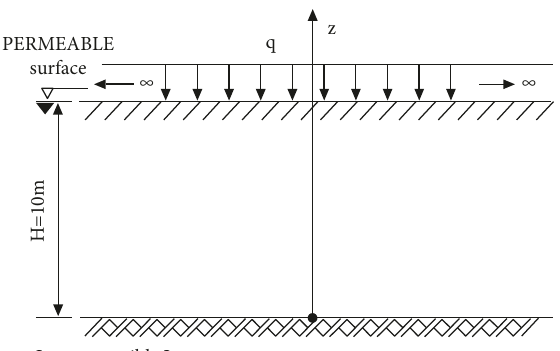
Figure 4: Schematic diagram of soft soil foundation.